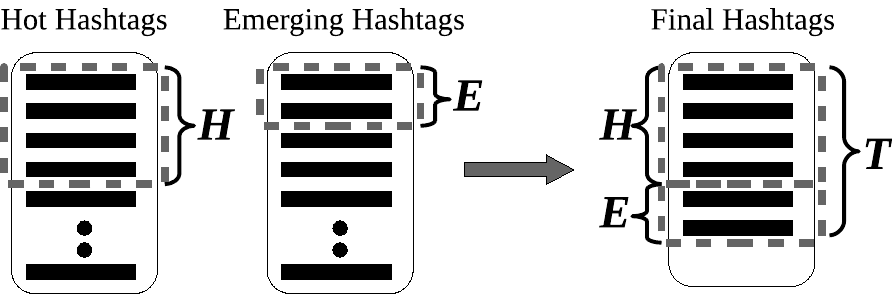
Figure 2. The final set contains T hashtags, which is a combination of the “hottest” ( H ) hashtags and the ones that are “emerging” ( E ) or rapidly rising. H and E are customizable for each